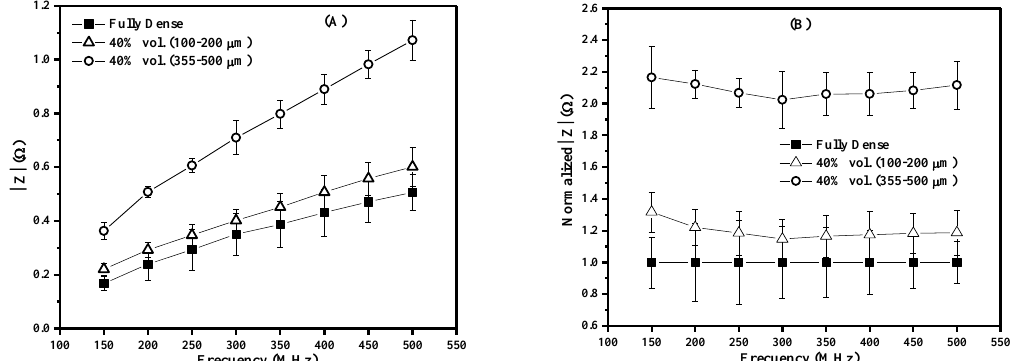
Figure 2. ( A ) Modulus of impedance, |Z|, and ( B ) normalized modulus of impedance, |Z| vs. frequency, measured for all specimens without cells and media.